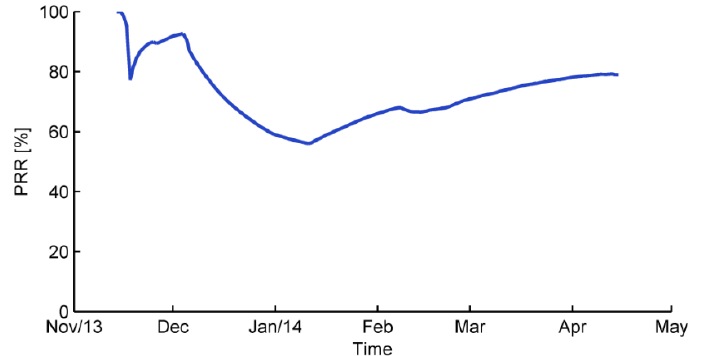
Figure 9. Network-level packet reception rate (PRR) during the CTP evaluation